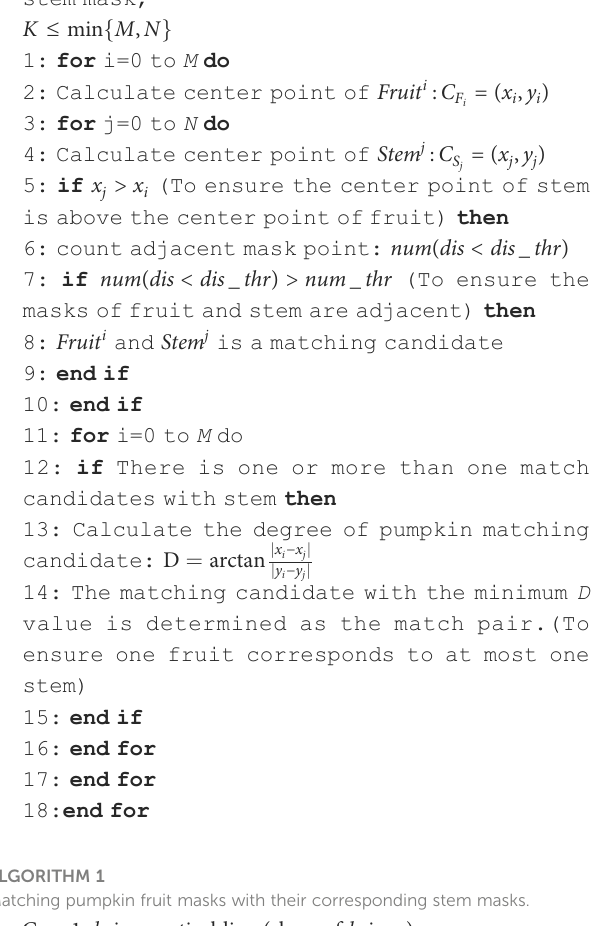
ALGORITHM 1 Matching pumpkin fruit masks with their corresponding stem masks.